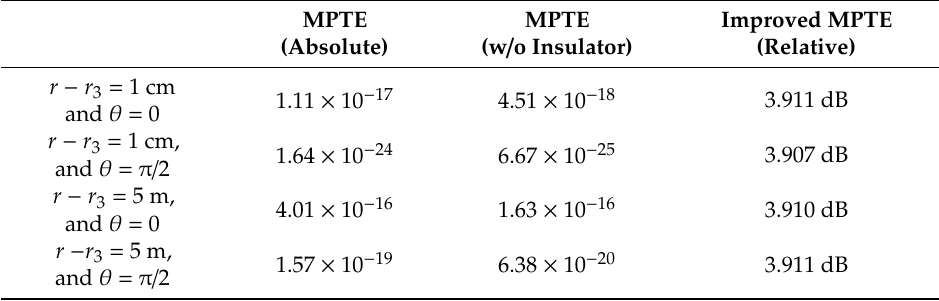
Table 2. Absolute and relative MPTE results by distance and angle between Tx and Rx when insulator is polyamide at 5.8